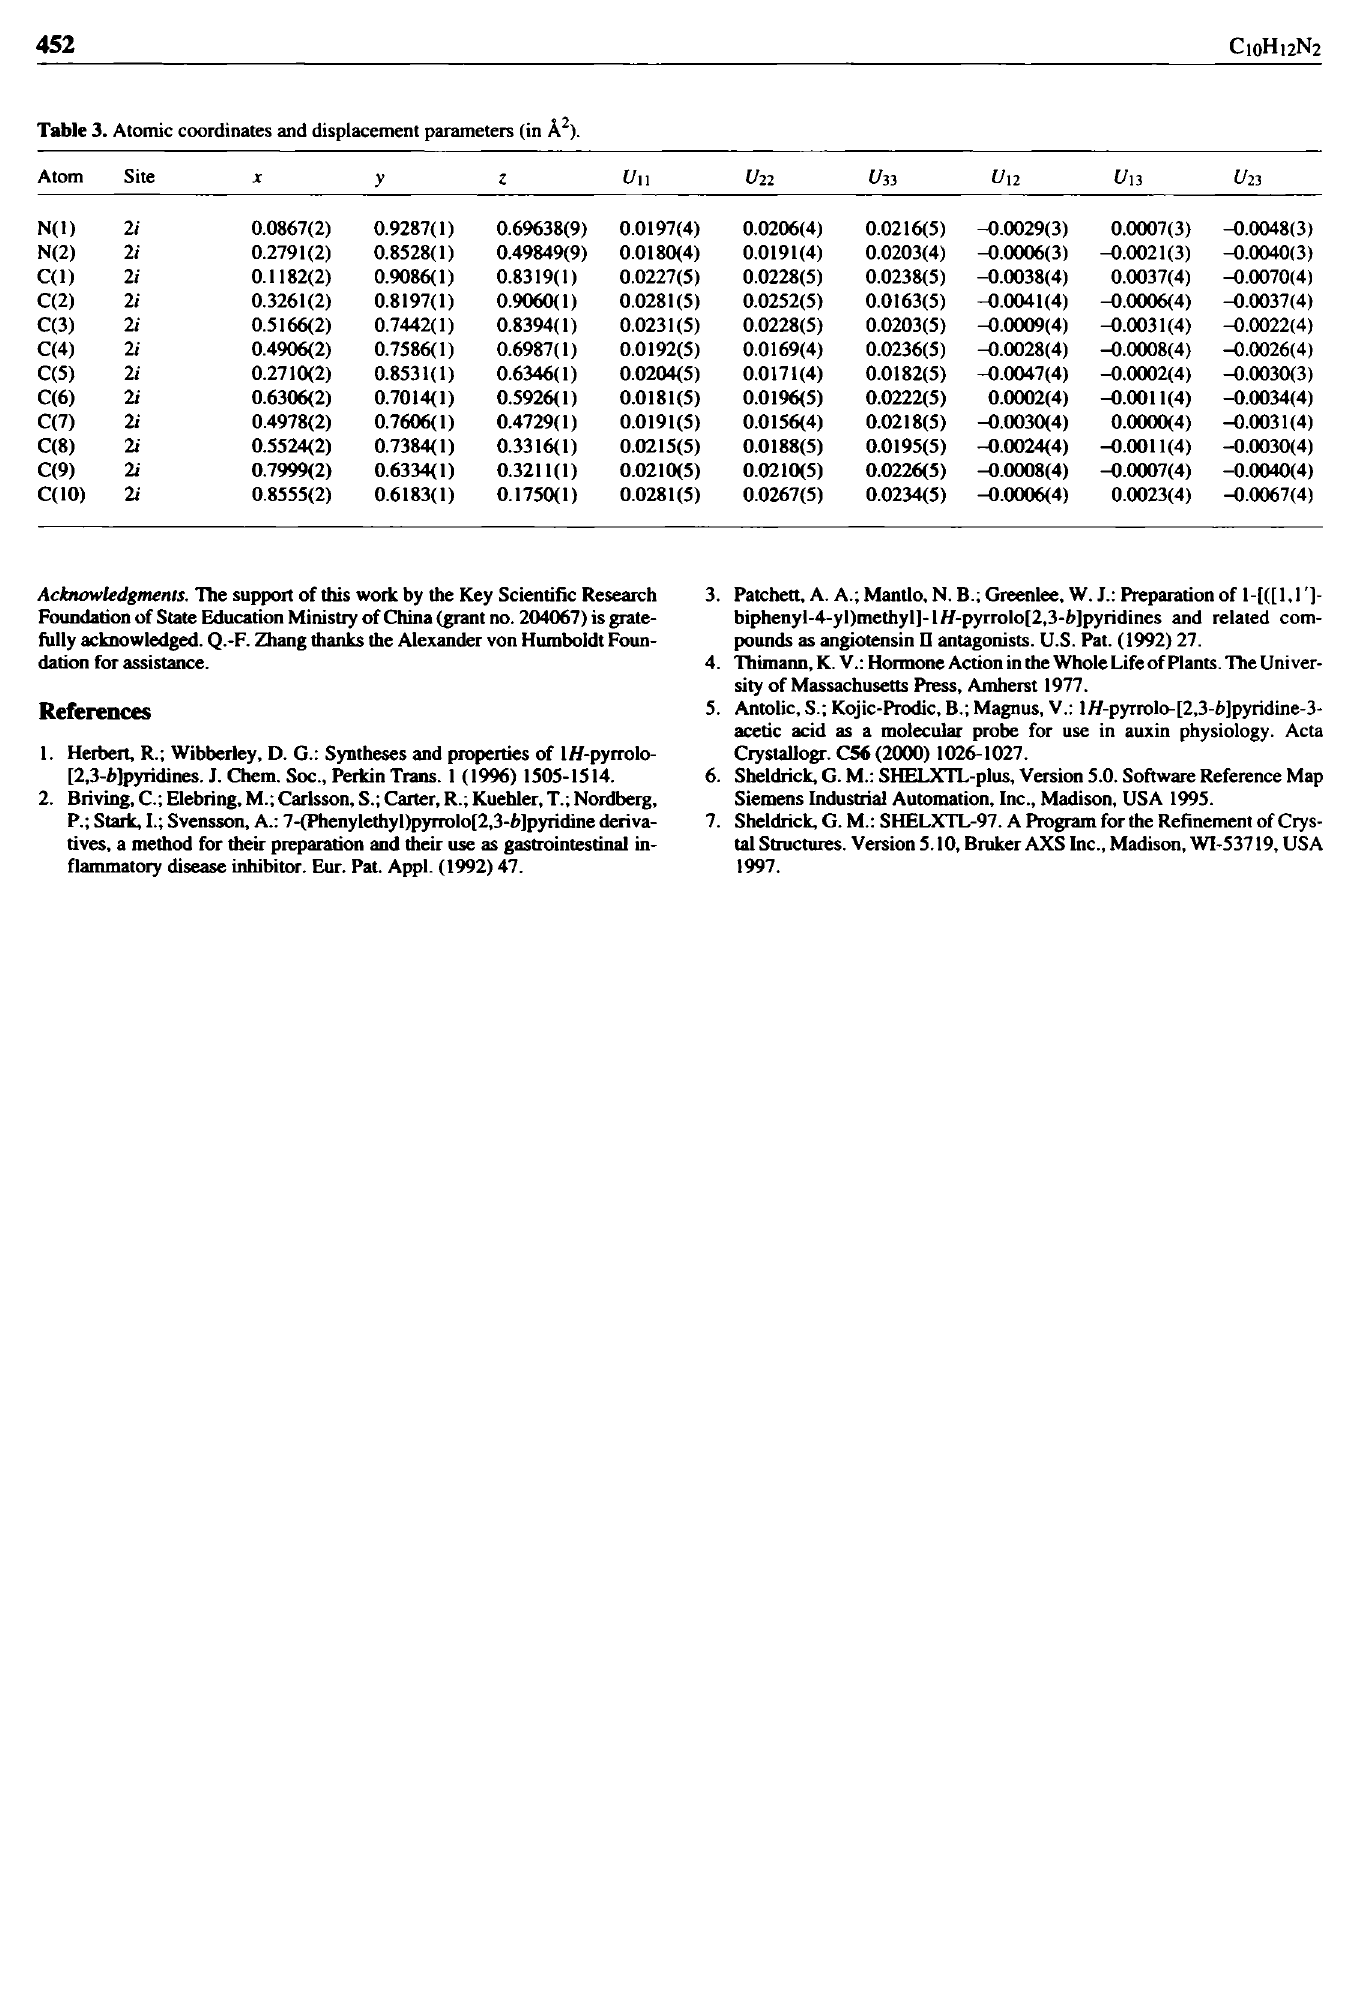
Table 3. Atomic coordinates and displacement parameters (in A 2